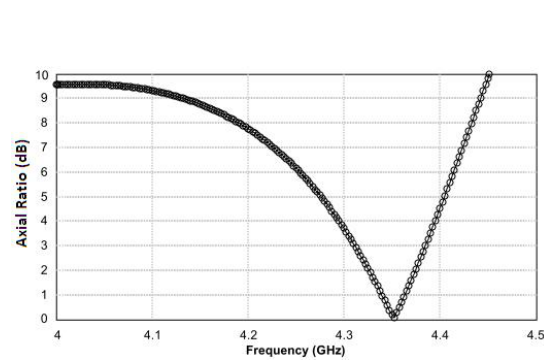
Figure 8. Variation of simulated axial ratio stacked antenna geometry with air gap and shorting pin.